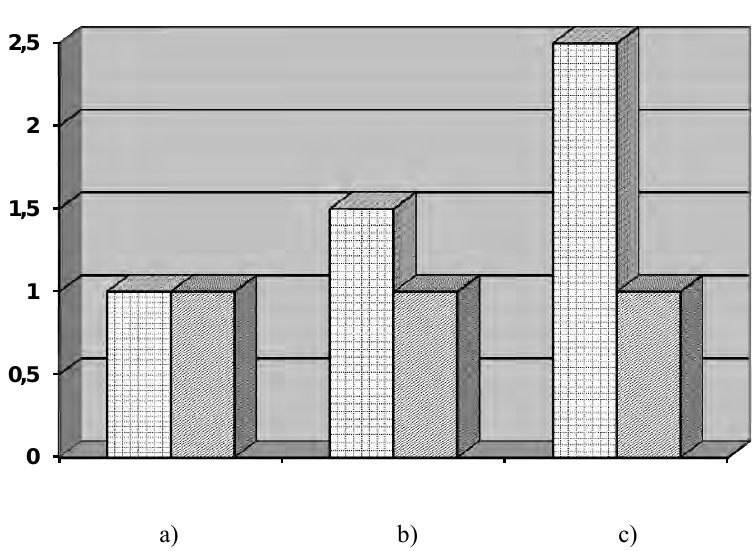
Fig.1. Results’ dynamic of three-step running high jump